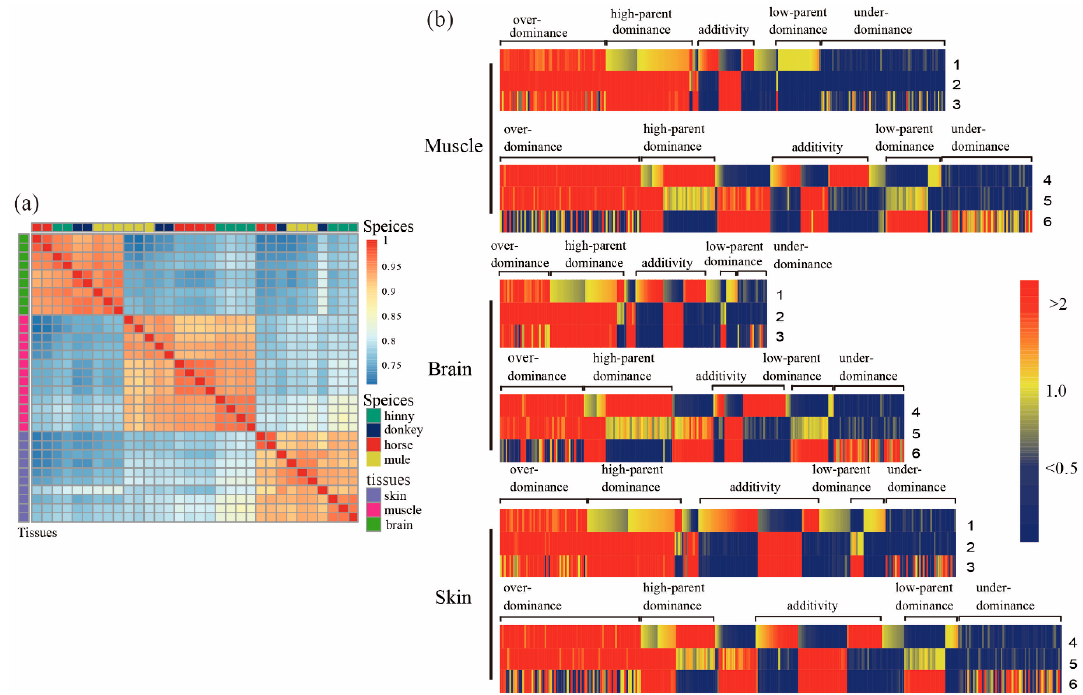
Figure 1. Differentially expressed genes (DEGs) in tissues of muscle, brain, and skin from mule, hinny, and their parents. ( a ) Pearson’s correlation of the expression profile of genes in the tissues of brain, muscle, and skin from mule, hinny, and their parents. The clustered results of gene expression among species are shown on the top, while the clustered results of gene expression in these tissues of species are shown on the right side. ( b ) Hierarchical clustering display of differentially expressed genes with the ratio of intensity according to expression patterns of genes in mule, hinny, and their parents. The color scale is shown at the top, and the mode of gene action is on the side. Lane 1 represents intensity ratios of mule to horse; Lane 2, intensity ratios of mule to donkey; Lane 3, intensity ratios of horse to donkey; Lane 4, intensity ratios of hinny to horse; Lane 5, intensity ratios of hinny to donkey; Lane 6, intensity ratios of horse to donkey.